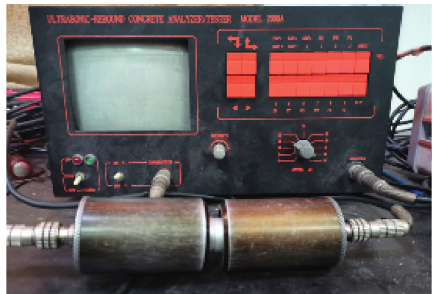
Figure 2: UTA2001A ultrasonic inspection